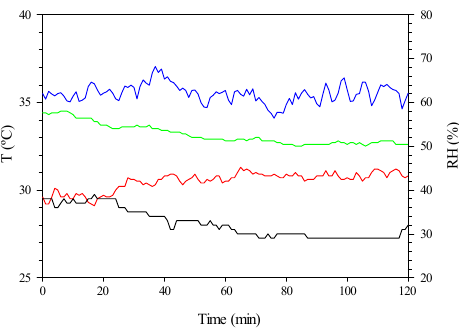
Figure 11. Temperature dynamics (indoor, green, and outdoor, red) and relative humidity (indoor, blue, and outdoor, black) during shading test 11 between 13:00 and 15:00 h.